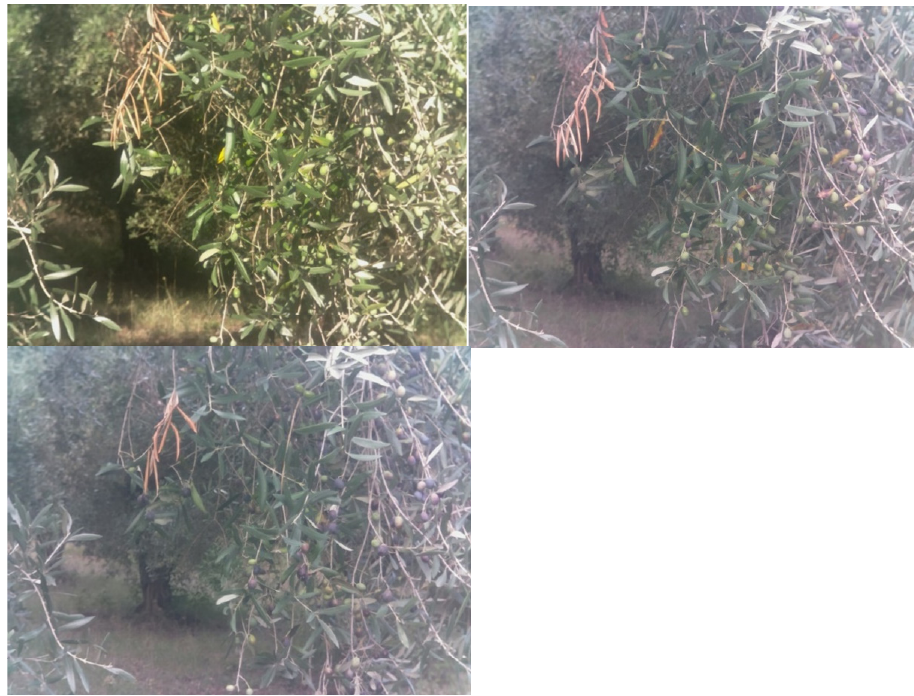
Figure 12. Pictures taken by automatic camera at three random days of the experiment. September 3rd (DOY 246) ( left – top ); 17th of September (DOY 259) ( right – top ); October 4th (DOY 277) ( left – down ). The image covering area was designed to represent the same fruit situation as fruits that were installed in the extensimeters. The collected images represented the canopy situation at the selected area.